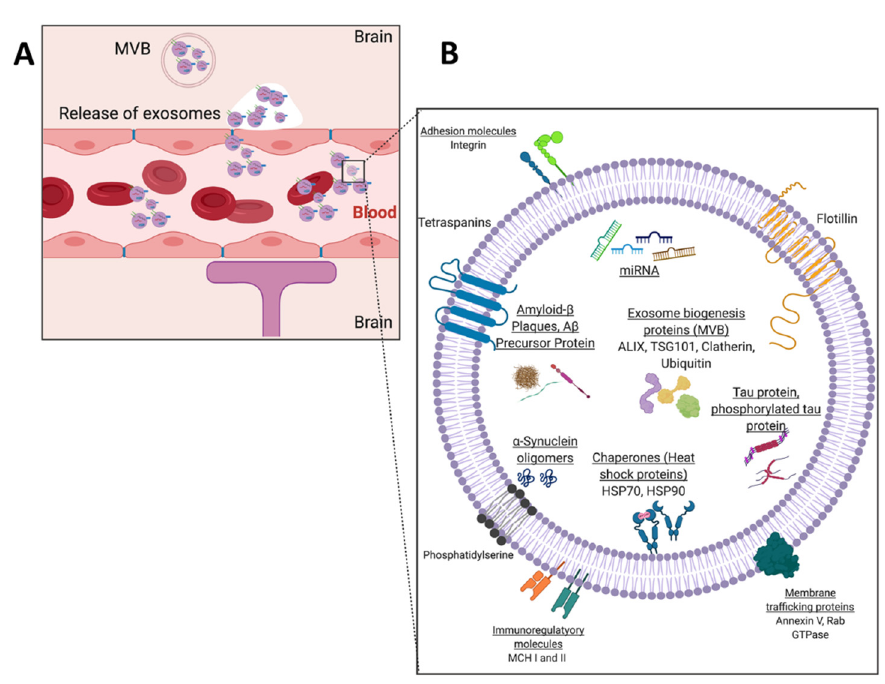
Figure 11. ( A ) Blood–brain barrier schematic with exocytosis of neural-derived exosomes from brain cells into bloodstream and ( B ) schematic example of a neural